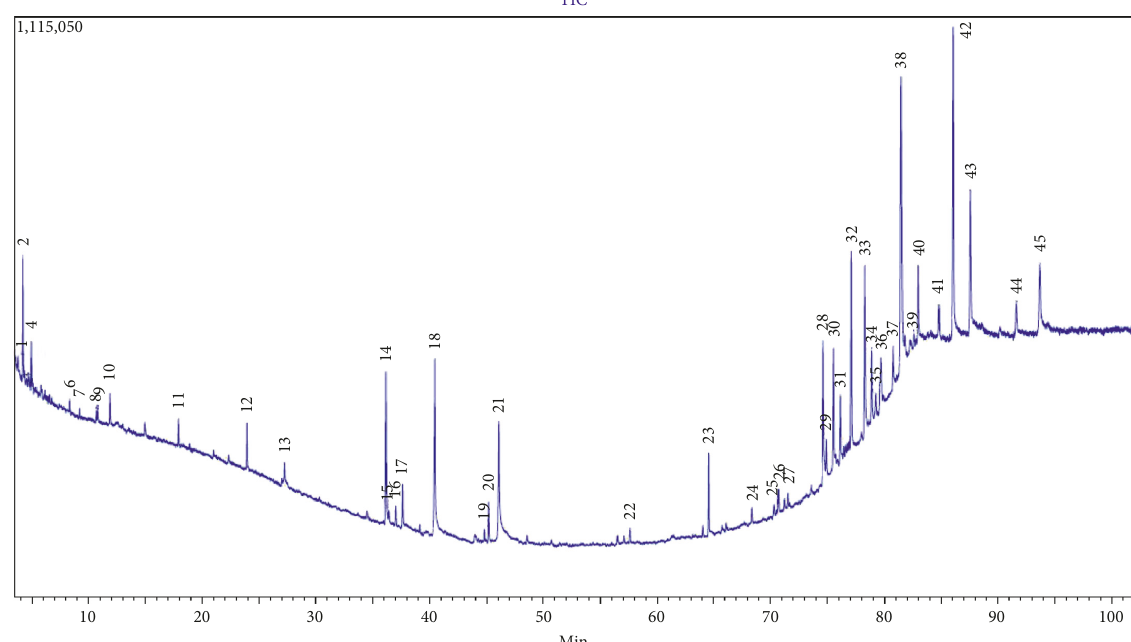
Figure 3: Chromatogram of GC-MS analysis of acetone extract of Azolla pinnata .